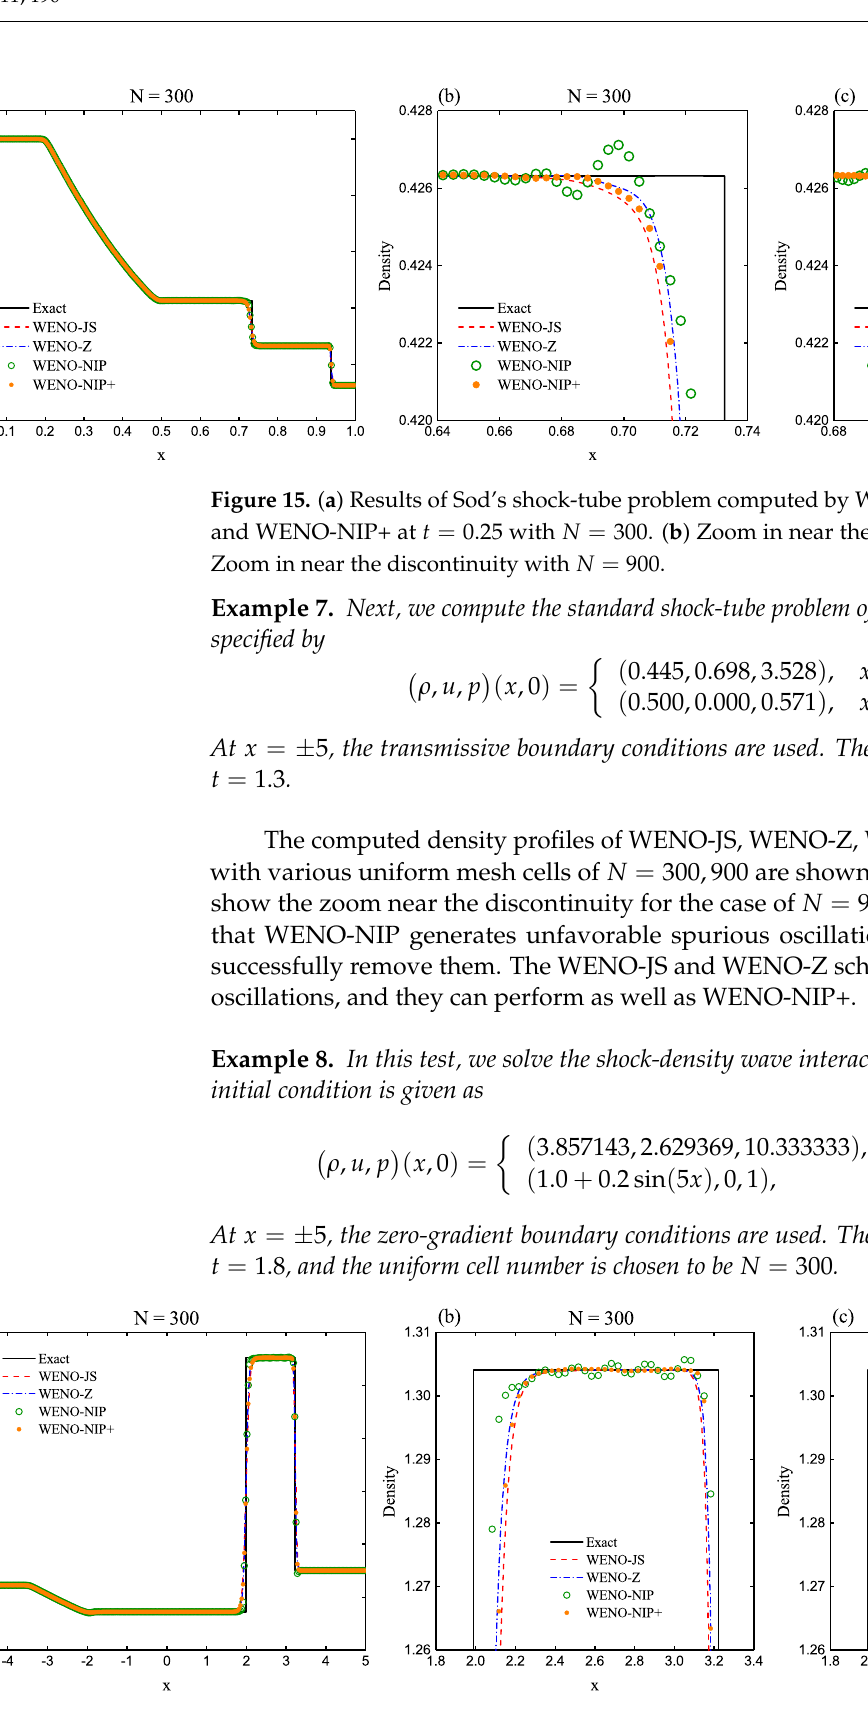
Figure 16. ( a ) Results of Lax’s shock-tube problem computed by WENO-JS, WENO-Z, WENO-NIP, and WENO-NIP+ at t = 1.3 with N = 300. ( b ) Zoom in near the top with N = 300. ( c ) Zoom in near the top with N =